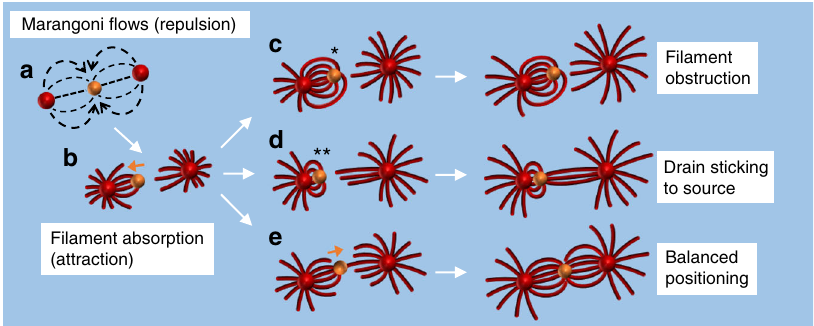
Fig. 5 Proposed mechanism that mediates the positioning of interconnected droplet- fi lament systems. a The Marangoni fl ows repel the drain (orange sphere) from the two sources (red spheres). b The Marangoni fl ow draws the fi laments to the drain. Upon absorption of these fi laments, the drain is drawn toward the source where these fi laments originate from. c The fi laments that are tethered to the drain obstruct the approach of fi laments from the second source droplet (indicated with *). d The drain sticks to the source via capillary forces (indicated by **) that inhibit the drain to be drawn away by fi laments arriving from the second source droplet. e Filaments that originate from the second source get absorbed at the backside of the drain, thereby generating attractive forces that draw the drain droplet back to the right, such that the Marangoni fl ows and the absorption of fi laments from both sources together mediate positioning of the drain in between both